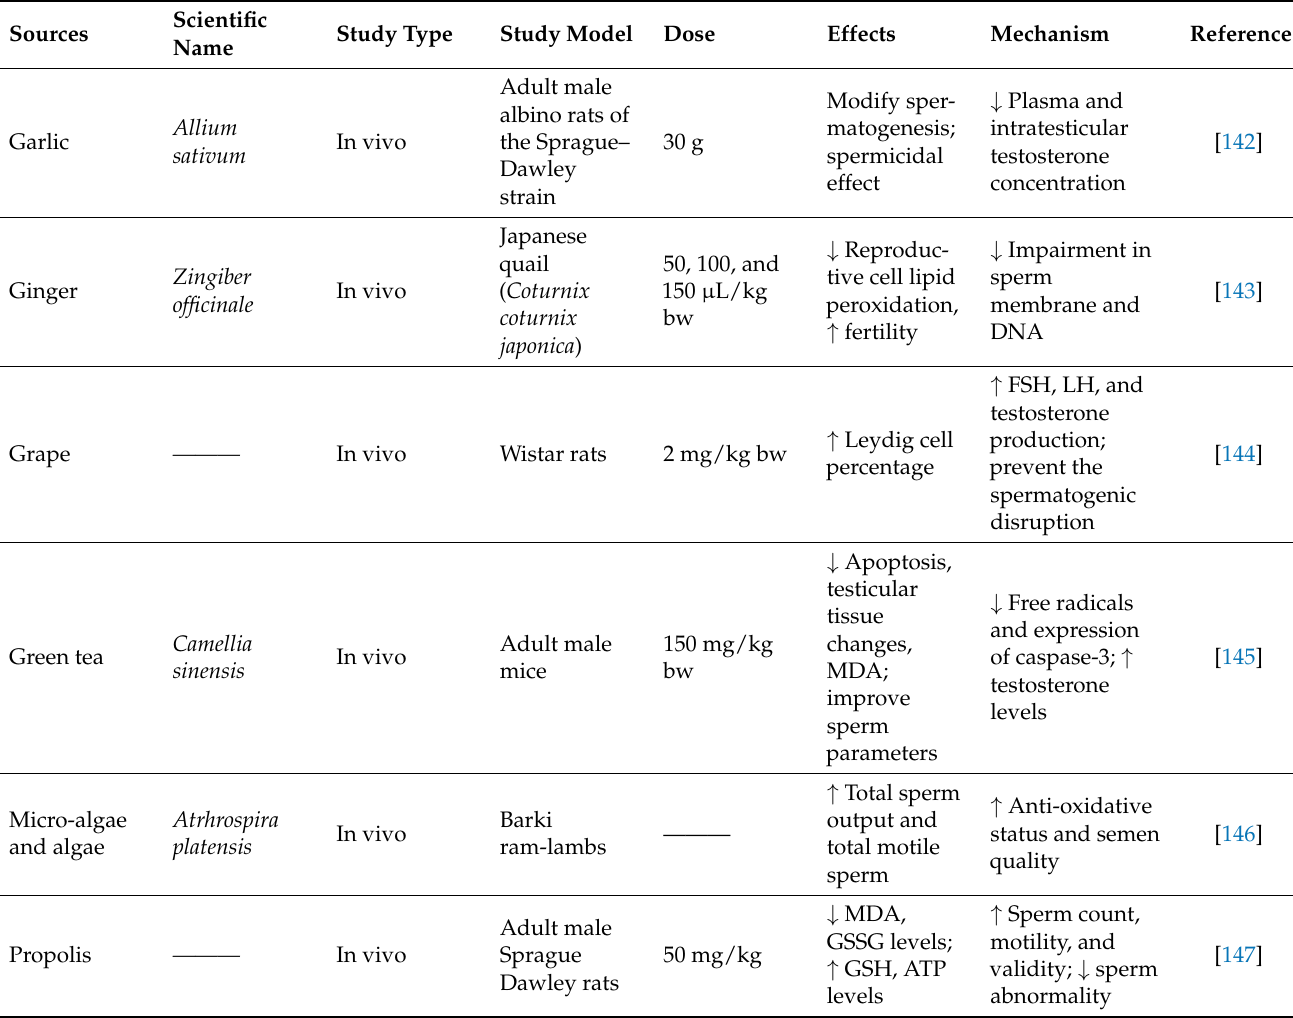
Table 2. The potential role of natural compounds in benefiting male fertility after COVID-19